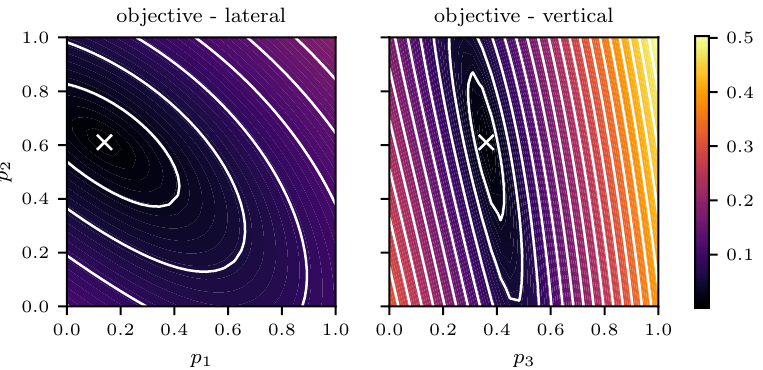
Figure 5. Contour lines of the objective function, the least squares error of Cu and Mn k-ratios from six electron beam positions and energies. In the left-hand plot, two parameters describing pixels lying next to each other are varied, and, in the right-hand plot, two parameters lying below each other are varied, see Figure 3 for the scenario, pixel size, and position. In both cases, all other parameters are fixed to their hidden truth values. The cross marks the hidden truth of the variable